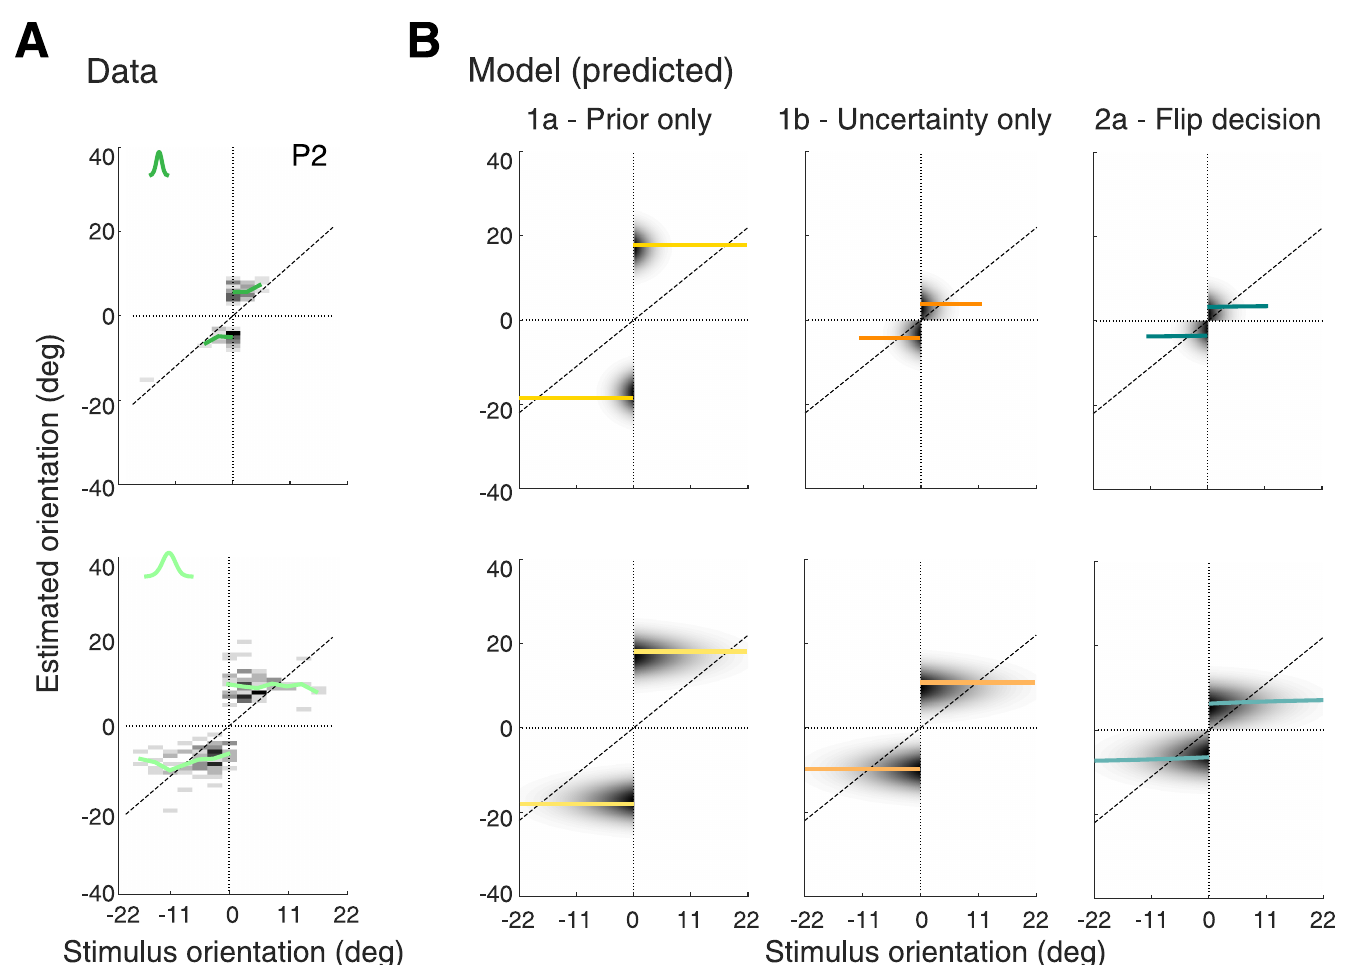
Fig 4. Experiment 1—Data and model predictions for incorrect trials. (A) Estimate distributions for incorrect trials (subject P2). Top row corresponds to low, bottom row to high stimulus noise. For stimulus orientations further away from the reference, the data get sparser because subjects made less incorrect decisions. Mean estimates (green lines; computed as the mean across all trials at each tested stimulus orientation) are approximately constant on each side of the decision boundary with magnitude and variance larger for higher stimulus noise. Also, distributions are long-tailed away from the reference orientation (see S8 Fig). (B) All models predict estimate distributions with approximately constant mean and variance across stimulus orientation. For Model 1a (prior only), however, mean and variance are independent of stimulus uncertainty with the variance determined only by motor noise. In contrast, the remaining two models (1b and 2a) correctly predict larger estimation means for higher stimulus noise, although only Model 2a predicts long-tailed distributions. Both models provide a good account of the data, which demonstrates that subjects indeed have access to information about sensory uncertainty after receiving negative feedback and can incorporate this information in their estimates. See S2 Fig for data of all other